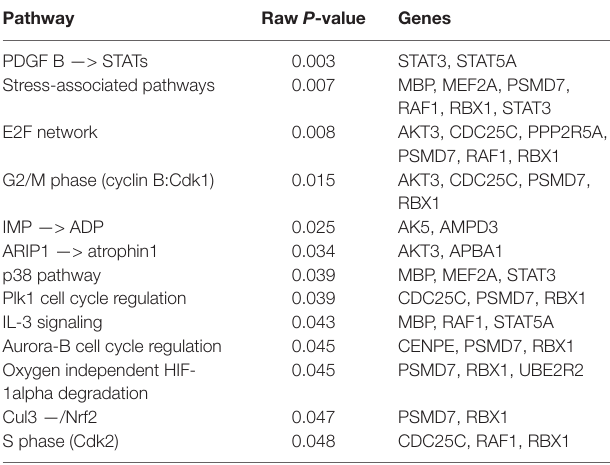
TABle 2 | Overrepresented pathways for the identified candidate signature genes.